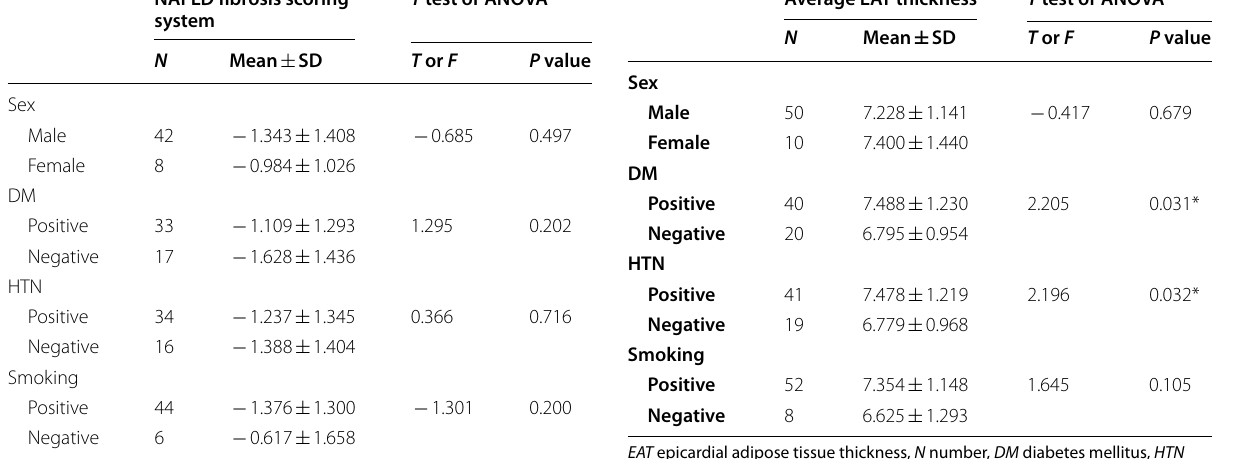
Table 6 Average EAT thickness in group A versus group B